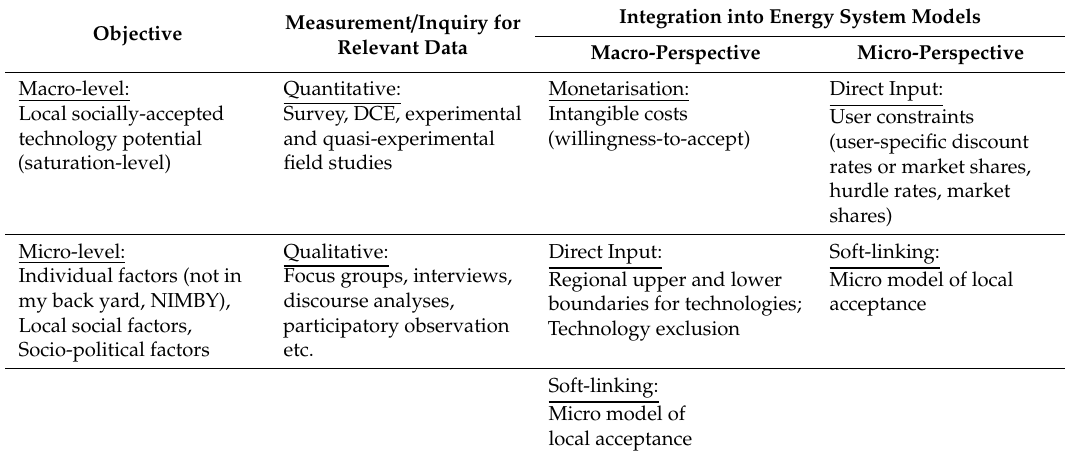
Table 2. Overview of objectives, methods of empirical data inquiry and possibilities to integrate aspects of local acceptance into energy system models